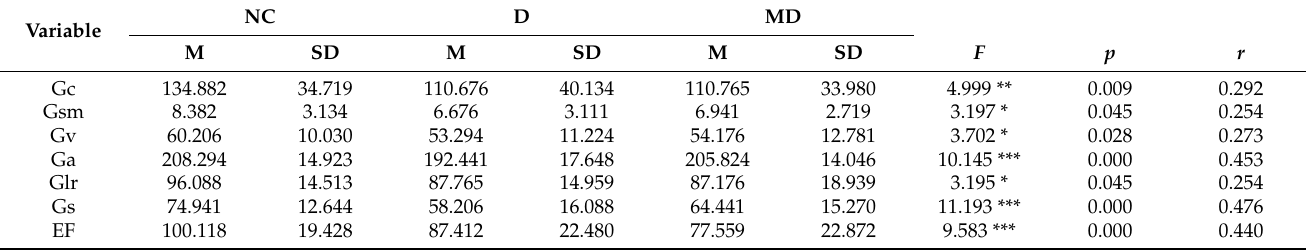
Table 5. The effect of CHC factors on the study groups (Normal children, Dyslexia, Math